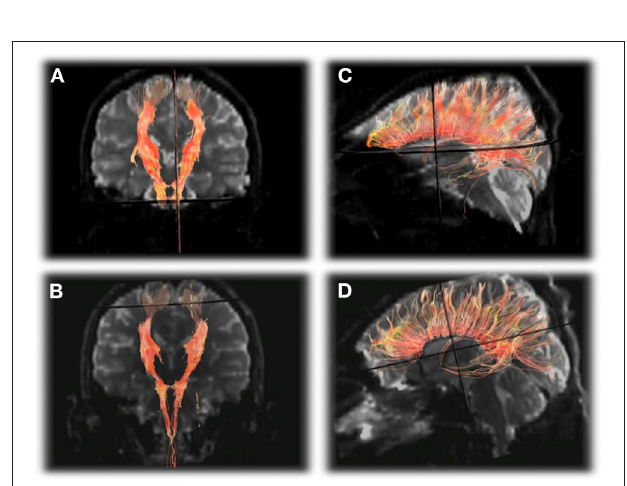
FIGURE 7 | DTI tractography of the corticospinal tracts displayed in the anterioroposterior plane (A,B) and corpus callosum displayed laterally (C,D) from the first exam (A,C) and final exam (B,D) showing subtle decrease in the number of projectional and commissural fibers over time. Reprinted from, with permission from IOS Press. Sen et al.